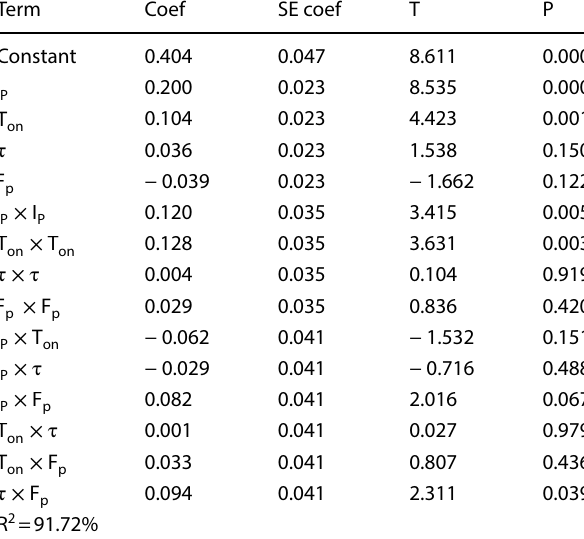
Table 7 ANOVA for MPCI Term